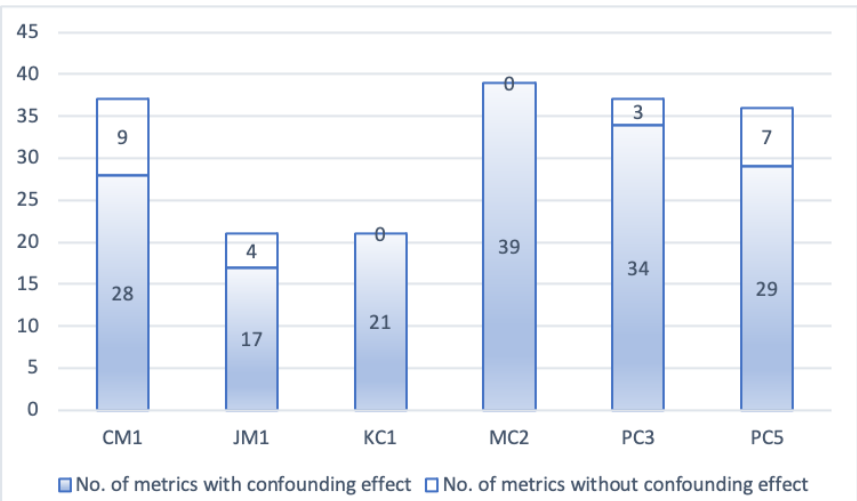
Figure 3. No. of metrics with and without confounding effect.